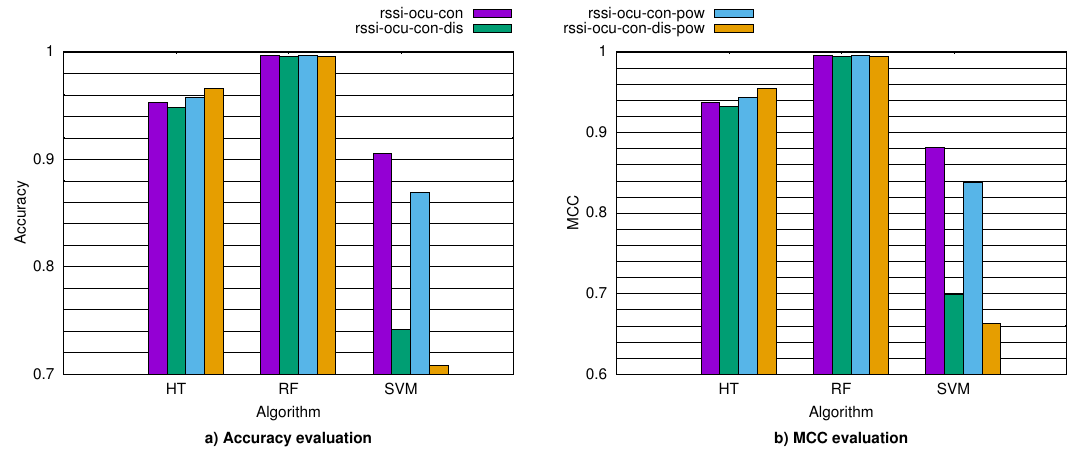
Figure 3. Feature selection; ( a ) Accuracy evaluation, ( b ) MCC evaluation.